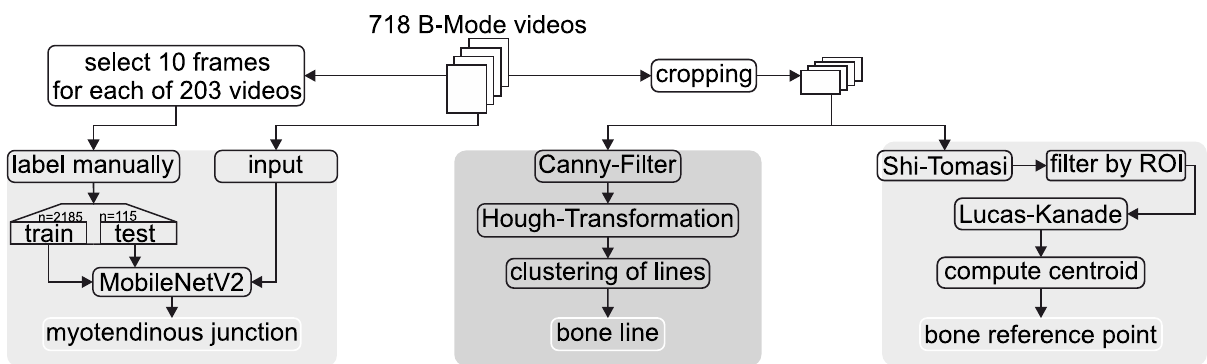
Fig 8. Block diagram for each computational method of feature extraction is shown. The computed features are from left to right: the mytendinous junction, bone line and bone reference point. The mytendinous junction is tracked with a neural network based on the MobileNetV2 algorithm. The bone line is tracked via Hough -Line-Transformation. The bone reference point is tracked by a method based on the Lucas-Kanade algorithm.